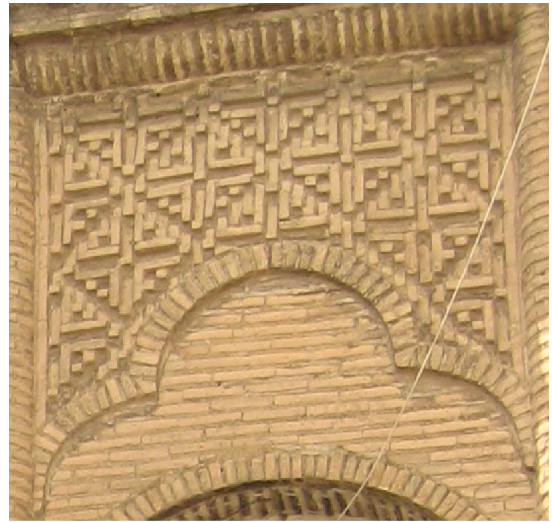
Fig. 11 Sar-Antary Xowun in Bozi Bozorg house. Source: MCHT of Dezful